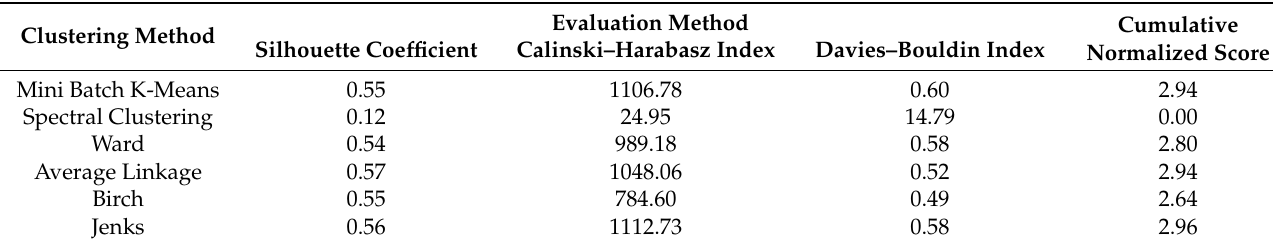
Table 9. Evaluation of clustering methods. The best evaluation score is shown in